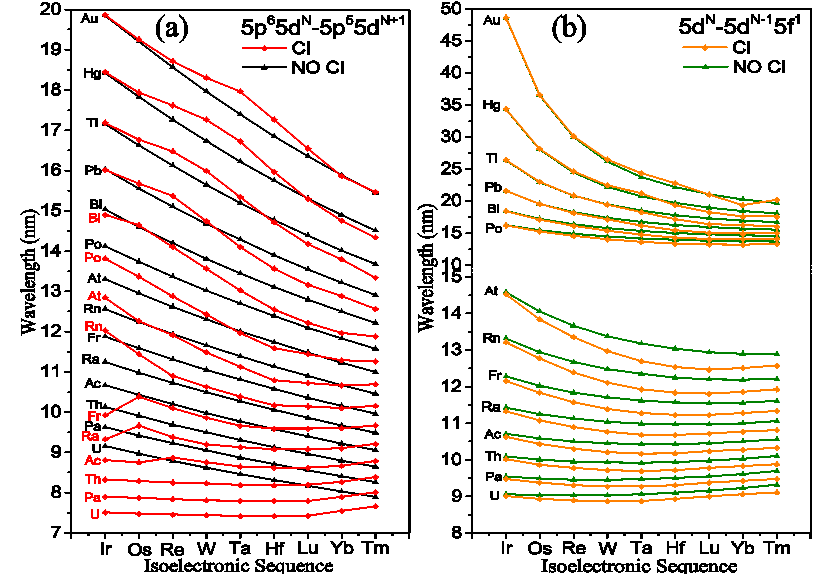
Figure 4. (Color online) Mean wavelength of transition arrays 5p 6 5d N+1 − 5p 5 5d N+2 and of 5p 6 5d N+1 − 5p 6 5d N 5f 1 Ir-like through Tm-like ions of gold through uranium ( a ) 5p 6 5d N+1 − 5p 5 5d N+2 including CI (red) and excluding CI (black); ( b ) 5p 6 5d N+1 − 5p 6 5d N 5f 1 including CI (orange) and excluding CI (green). Table 1. Calculated mean wavelength λ gA (nm) and spectral width ∆ λ gA (nm) for the UTA of gold through astatine ions: Ir-like to Tm-like ions for the 5d – 5f arrays without and with the effect of configuration